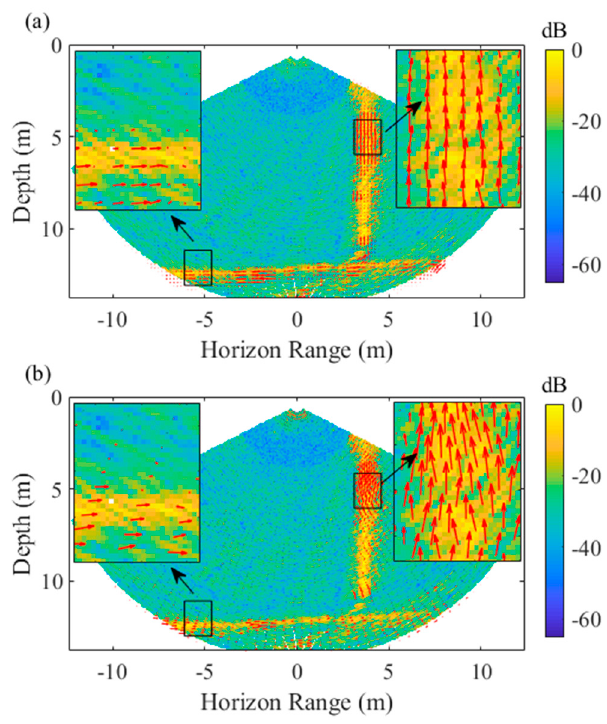
Figure 13. The joint display of the WCI and velocity field estimated by frame A ( a ) and frame B ( b ), respectively, from the experimental data of a measurement period in Songhua Lake.